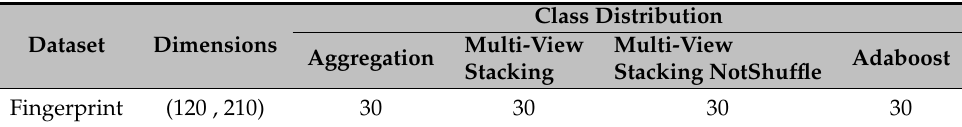
Table 6. Balanced Fingerprint